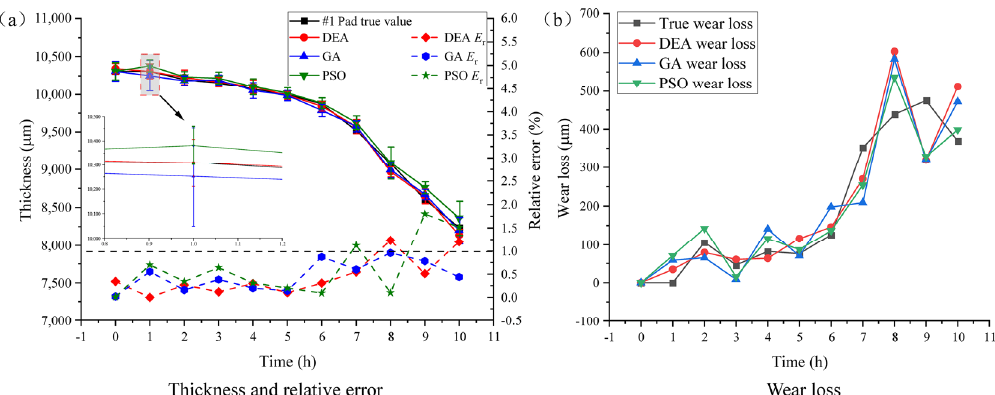
Fig. 26 Identification results of different intelligent algorithms of the #1 pad.